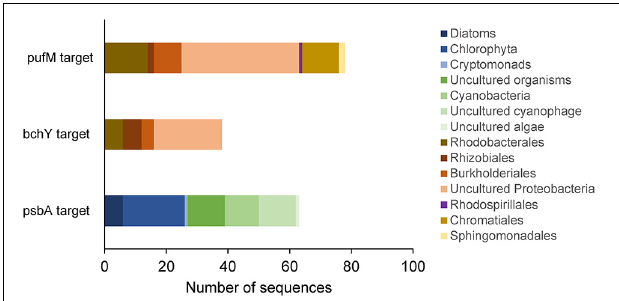
FIGURE 7 | Taxonomic composition of all samples based on three marker genes targeted sequences, puf M, bch Y, psb A.